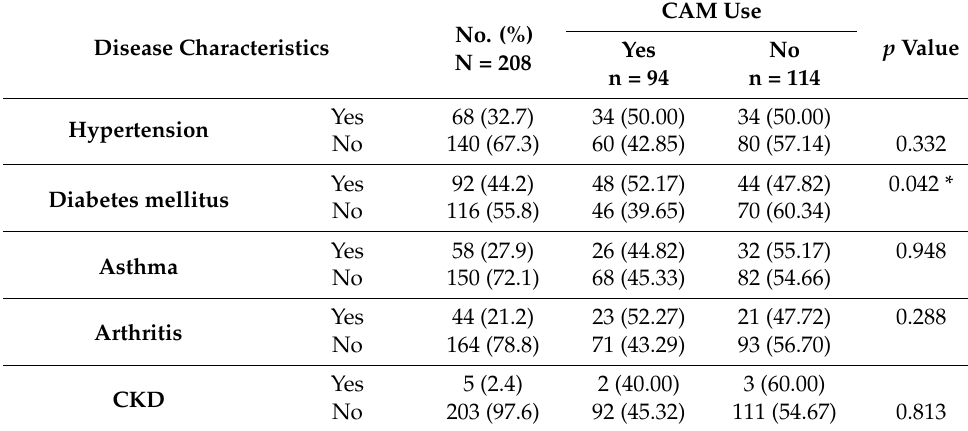
Table 2. Disease characteristics of CD patients and CAM use.